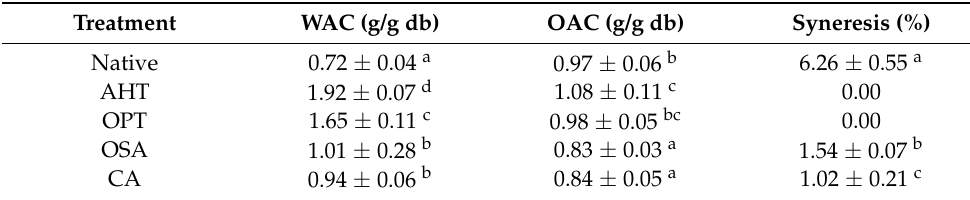
Table 5. Water absorption capacity (WAC), oil absorption capacity (AOC), and syneresis of native and modified sago